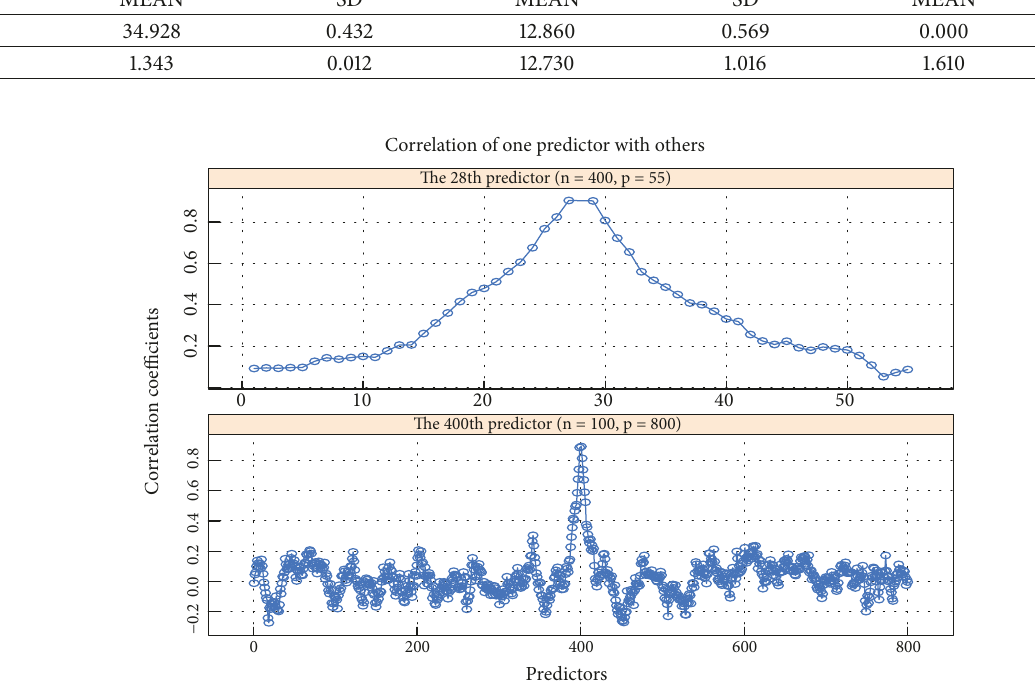
Figure 2: The top subgraph is correlation coefficient path of the 28th predictor with other 54 predictors. The subgraph below is correlation coefficient path of the 400th predictor with other 799